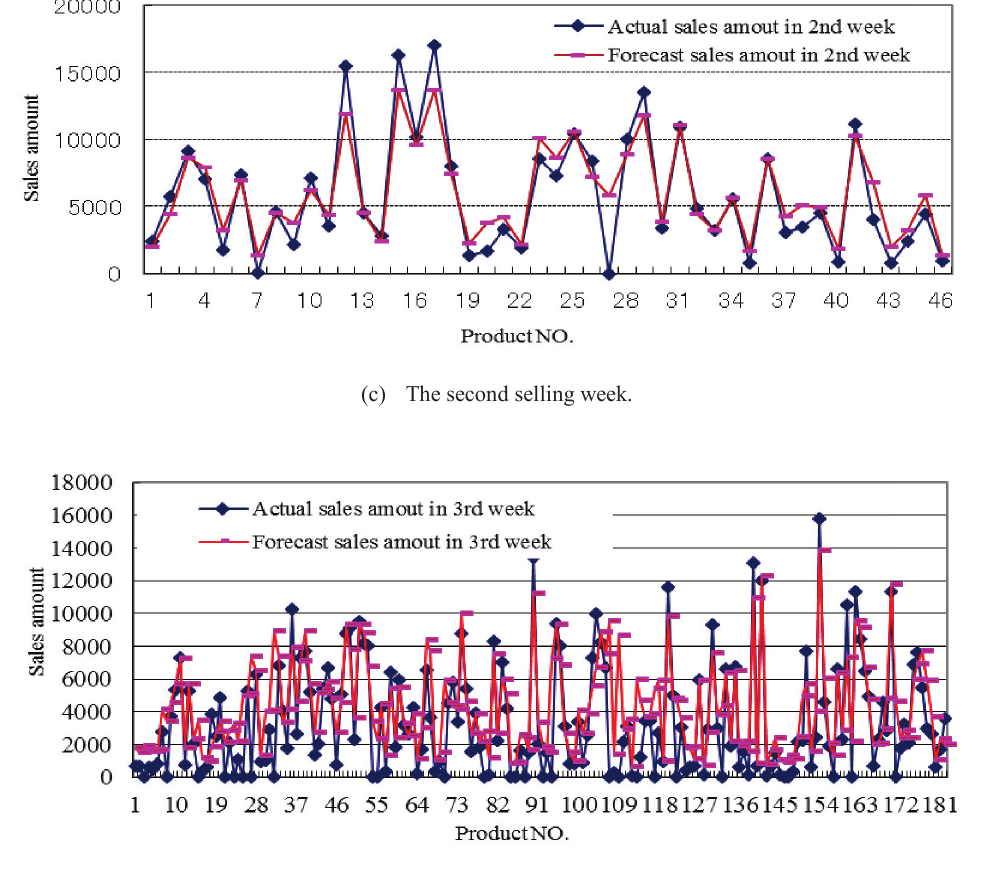
Fig. 7. Forecasting result using verification data.